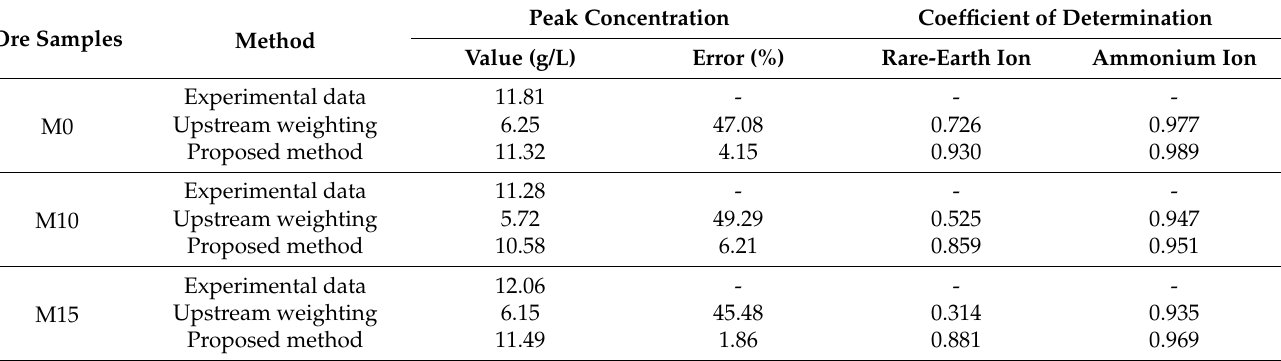
Figure 9. Breakthrough curves of ammonium ions and rare-earth ions: ( a ) M0, ( b ) M10, and ( c ) M15. Table 3. Parameter comparison between the test and calculation